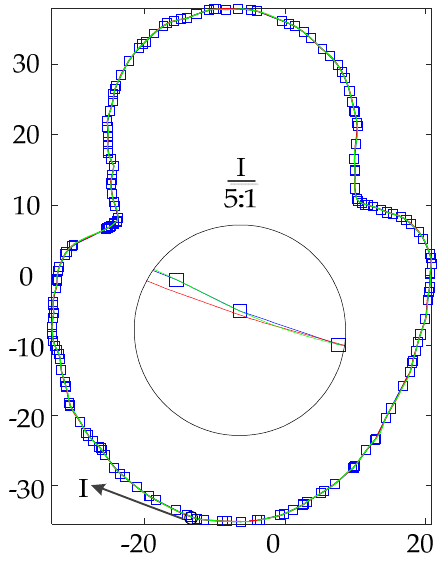
Figure 10. Slicing data and contour fitting.